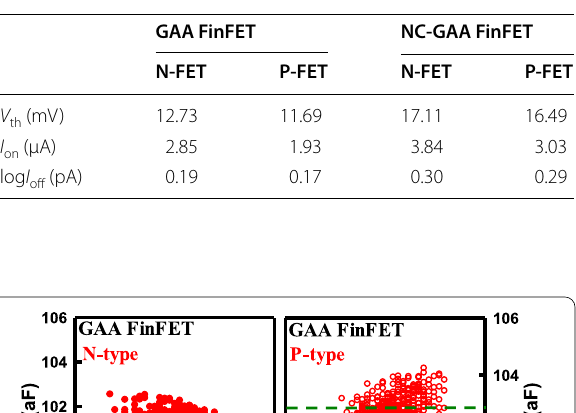
Table 5 The standard deviation of V GAA and NC‑GAA FinFETs under the same MGN (MGN